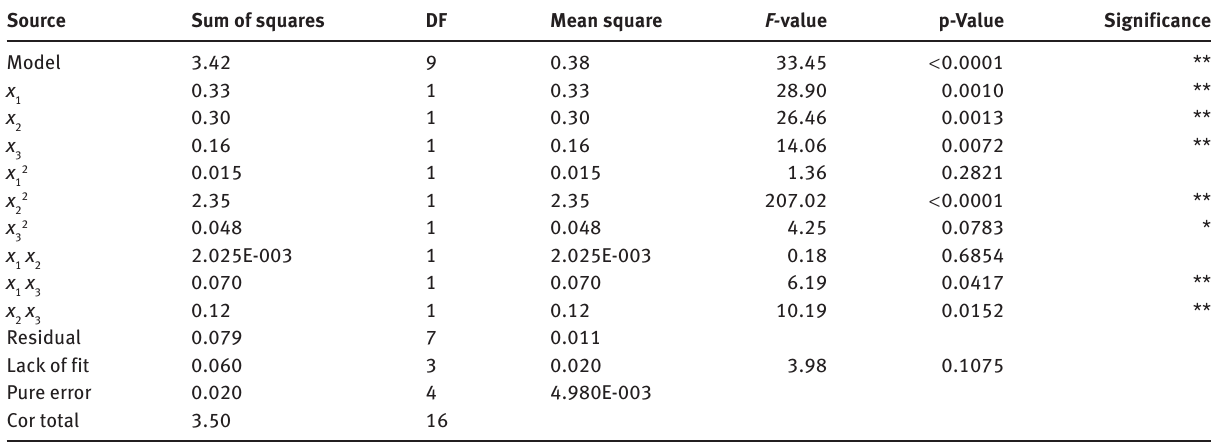
Table 4: Estimated regression coefficients and corresponding statistical F - and p-values for butyl butyrate yield.